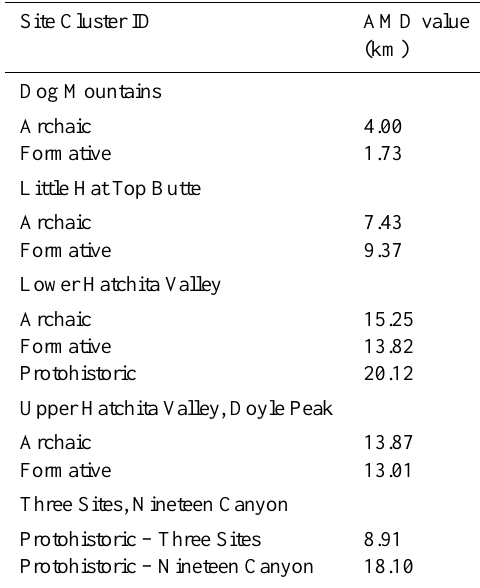
Table 3. AMD values by locality